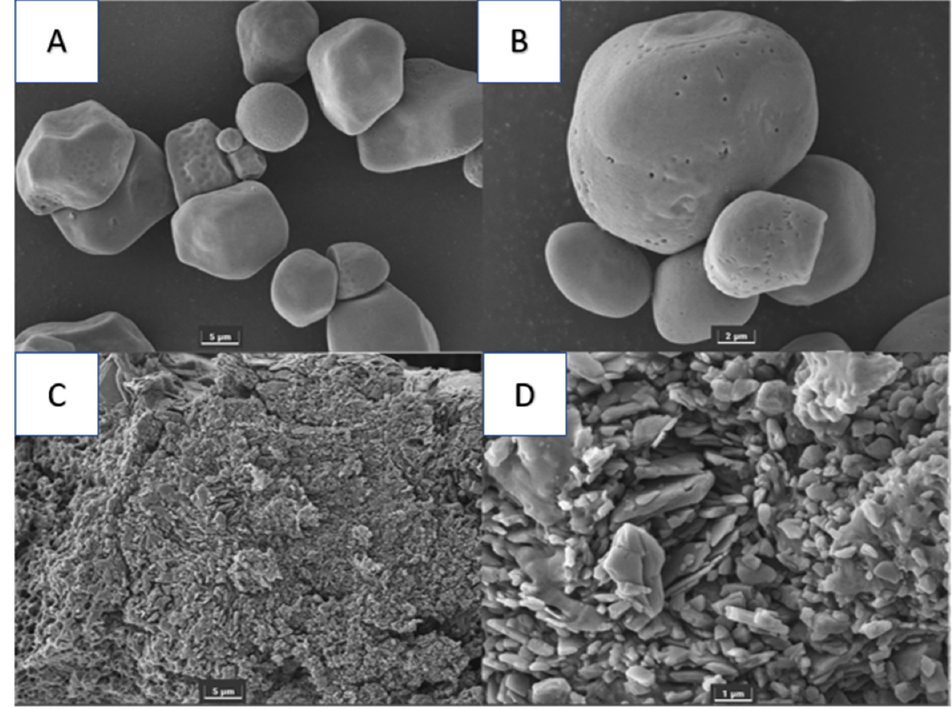
Figure 3. SEM photographs: initial starch (magnification 2000 ( A ) and 5000 ( B )); causticized starch (magnification 2000 ( C ) and 10,000 ( D